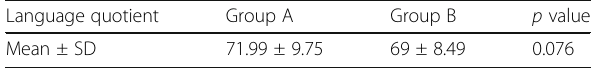
Table 3 Language quotients in study groups prior to